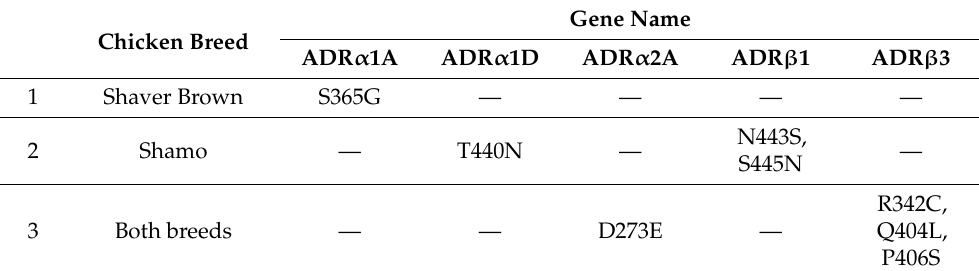
Table 3. The eight amino acid mutation sites in the five adrenergic receptor (ADR) genes in Shamo and Shaver Brown